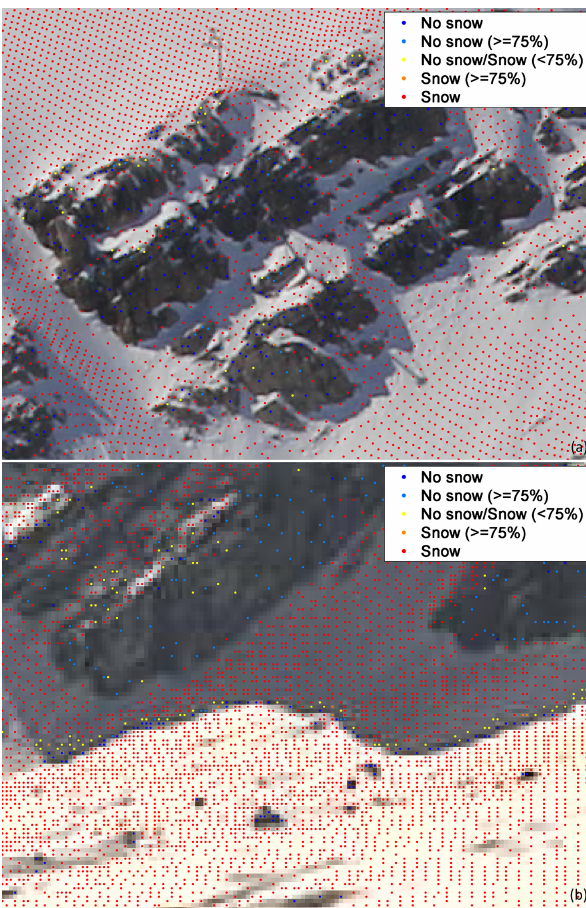
Figure 11. Enlarged view of the superimposed snow classifications on the SLR and webcam photographs of 7 April 2014 (rectangle boxes in Fig. 11c and d): (a) unsure classification results in the SLR photograph are located at transitional areas between snow patches and snow-free areas. (b) In the webcam photograph, more pixels are classified in the three unsure categories. Moreover, some no snow misclassifications are found at the transitional zone between sunny and shaded snow cover.